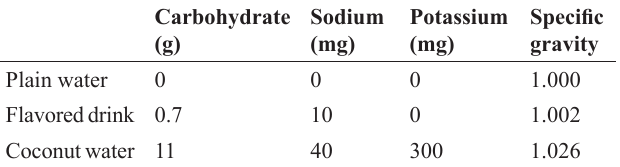
Table 2. Drink composition.